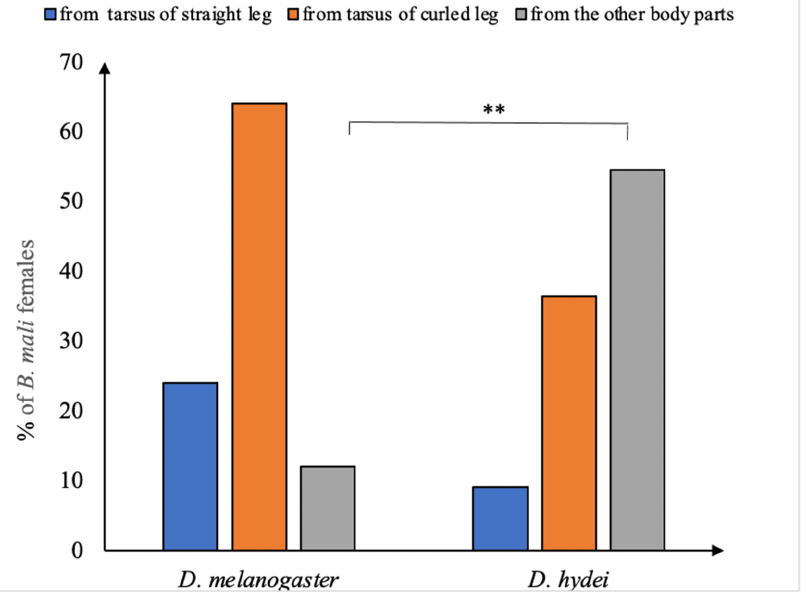
Figure 2. Percentage of Blattisocius mali females that located on D. melanogaster and D. hydei fruit flies during the first hour of observation using a particular way of getting on the fly’s body. ** 0.001 < p < 0.01.